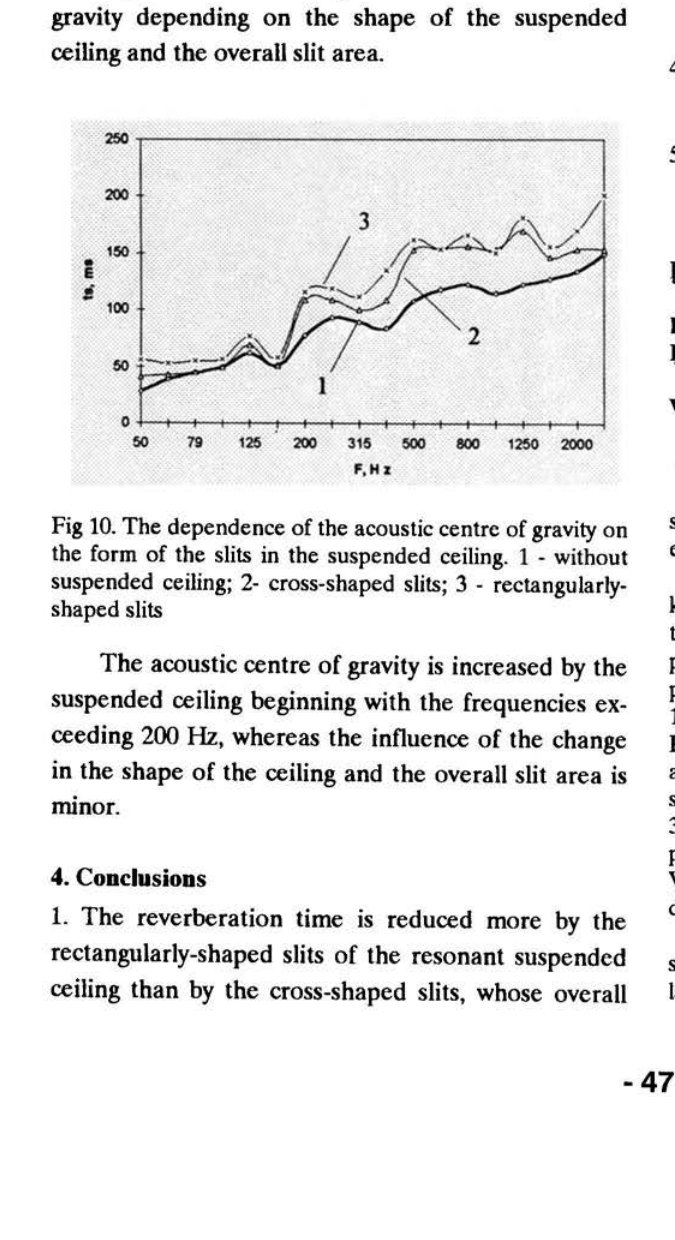
Fig 9. The dependence of the music sound clarity index on the shape of the suspended ceiling. 1 - without suspended ceiling; 2- cross-shaped slits; 3 - rectangularly-shaped slits The music sound clarity index is started to be af fected by the shape of the suspended ceiling from 200 Hz on. Then the values of the index are larger, with the both shapes of suspended ceiling, than in the case when the hall has no suspended ceiling.